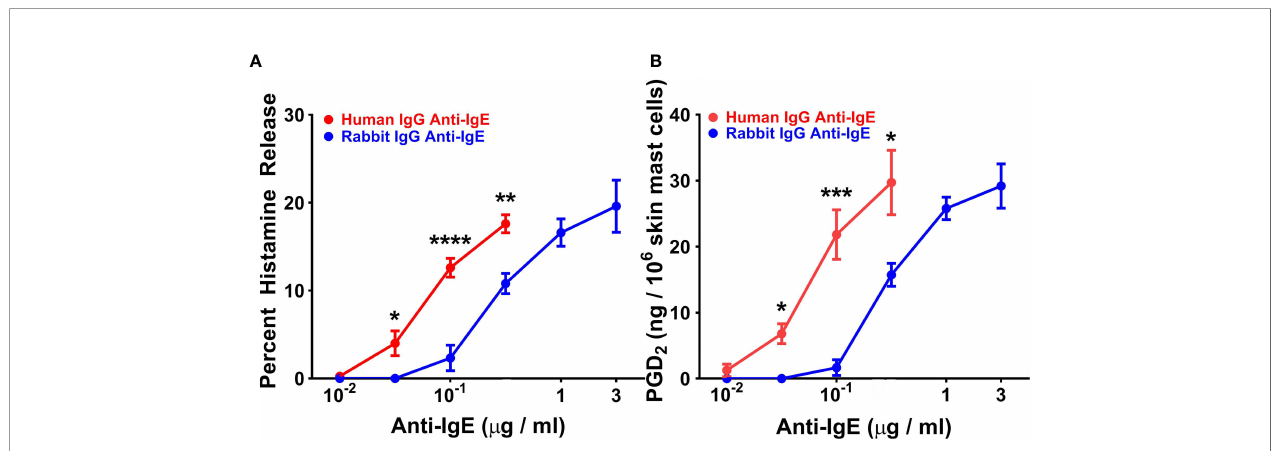
FIGURE 4 | Effects of increasing concentrations of human IgG anti-IgE and rabbit IgG anti-IgE on HR (A) and the de novo synthesis of PGD 2 (B) from HSMCs obtained from fi ve different donors. HSMCs were incubated (45 min at 37°C) in the presence of the indicated concentrations of human IgG anti-IgE or rabbit IgG anti-IgE. Each point shows the mean ± SEM. **** p < 0.0001, *** p < 0.001, ** p < 0.01, * p < 0.05 when compared to the corresponding value. Error bars are not shown when graphically too